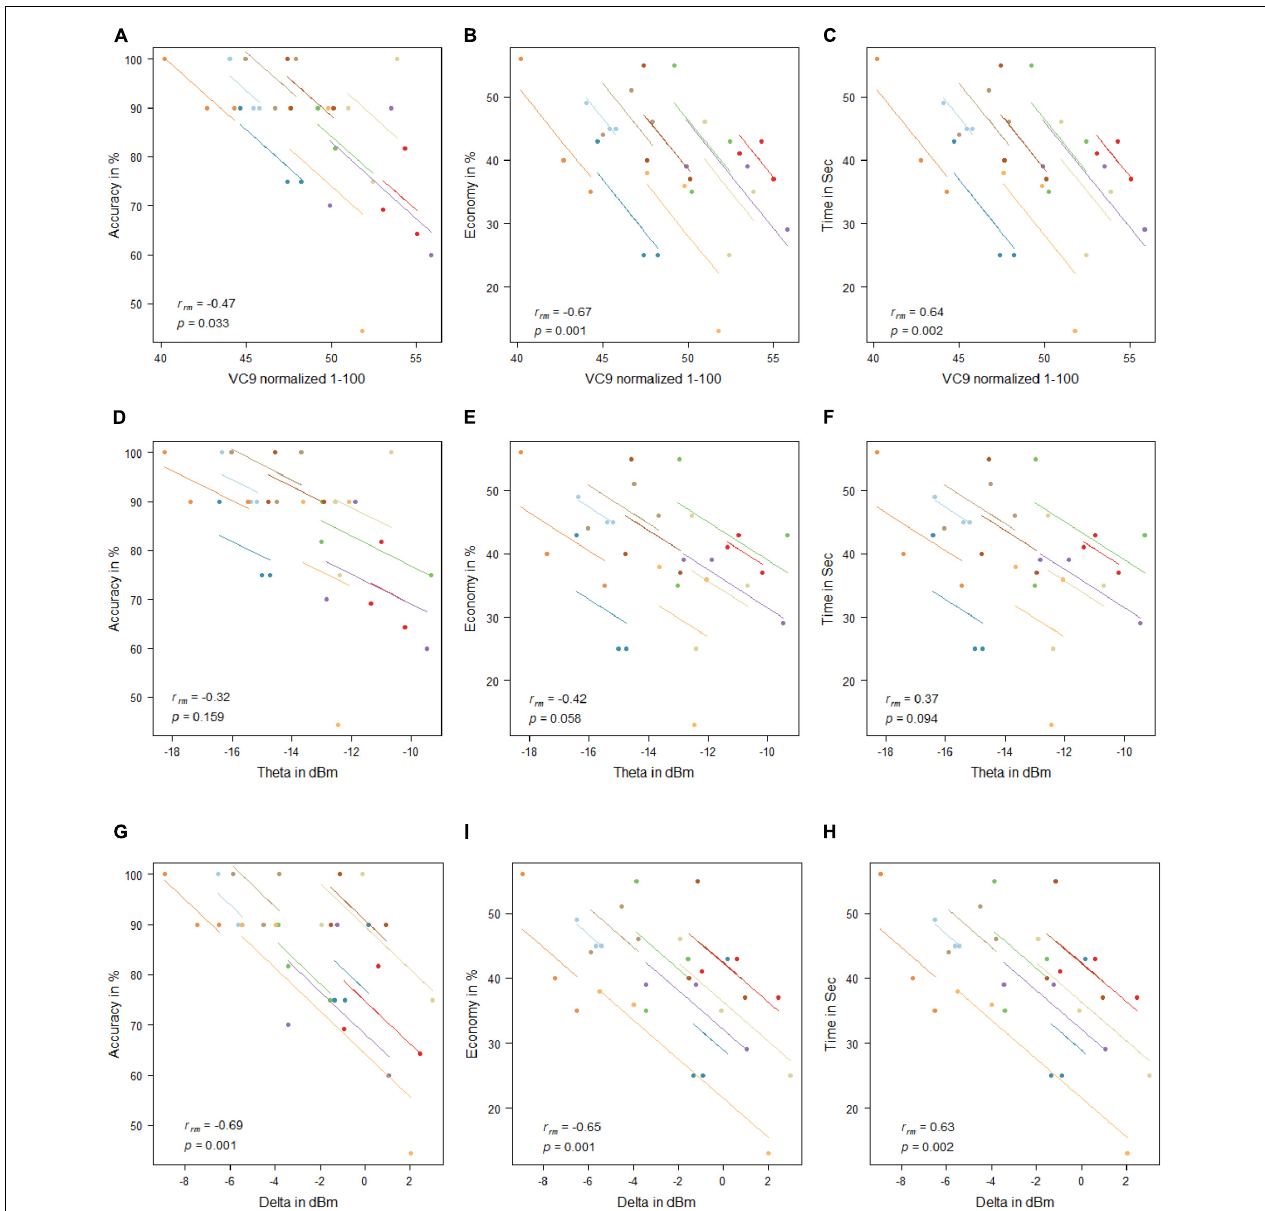
FIGURE 7 | Mean activity of VC9 as function of accuracy (A) , economy (B) , and time (C) ; theta as function of accuracy (D) , economy (E) , and time (F) ; and delta as function of accuracy (G) , economy (H) , and time (I) per trial and participant obtained in Experiment 2 ( n = 10). R rm and p- values presented.